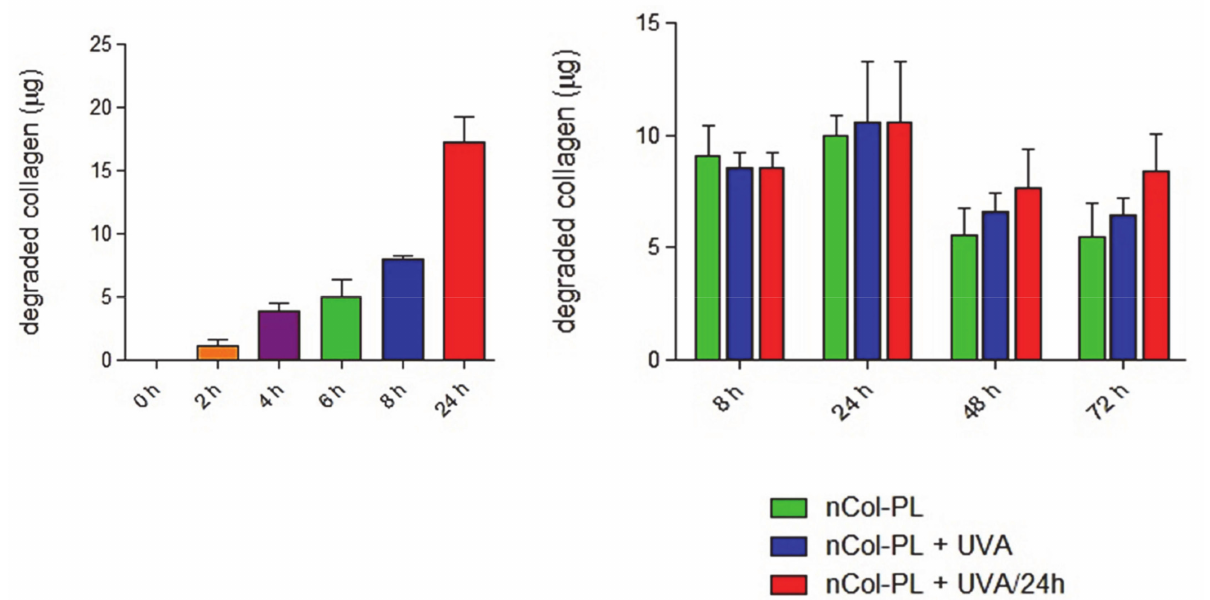
Figure 6. Collagenase kinetics of collagen degradation. Left: Quantification of the amount of degraded collagen ( µ g) throughout 24 h, for the indicated time-points. Right: Quantification of the amount of degraded collagen ( µ g) throughout 72 h for the indicated time-points, after incubation with non-UVA treated nanocapsules (nCol-PL, green bar), single-UVA treated nanocapsules (nCol-PL + UVA, blue bar) or nanocapsules treated with UVA pulse each 24 h (nCol-PL + UVA/24 h), red bar). Bars represent mean ± standard error of the mean ( n =